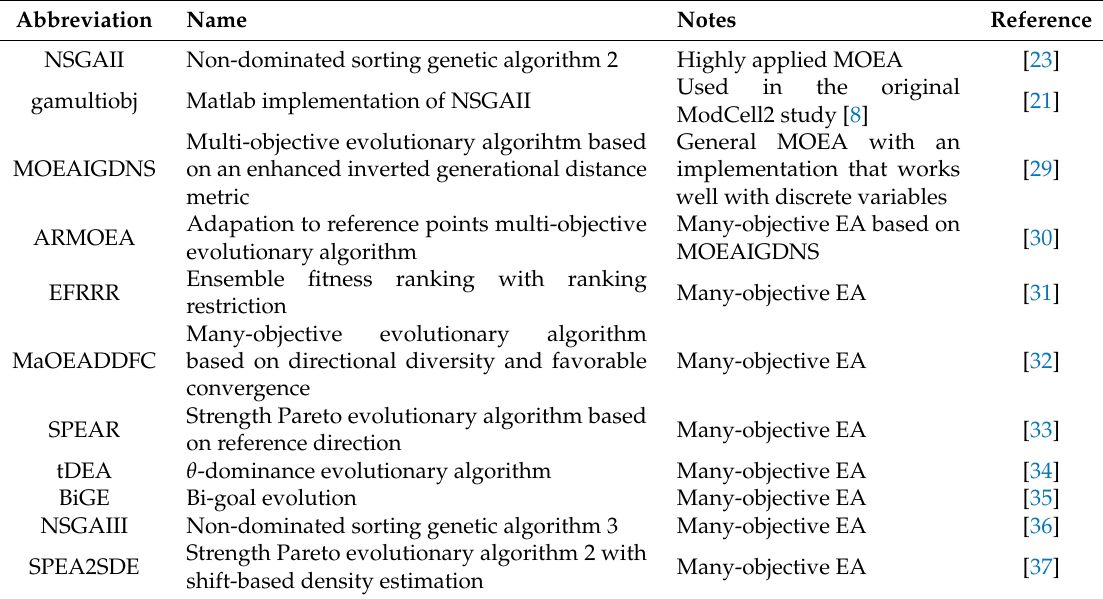
Table 1. Summary of MOEAs used in this